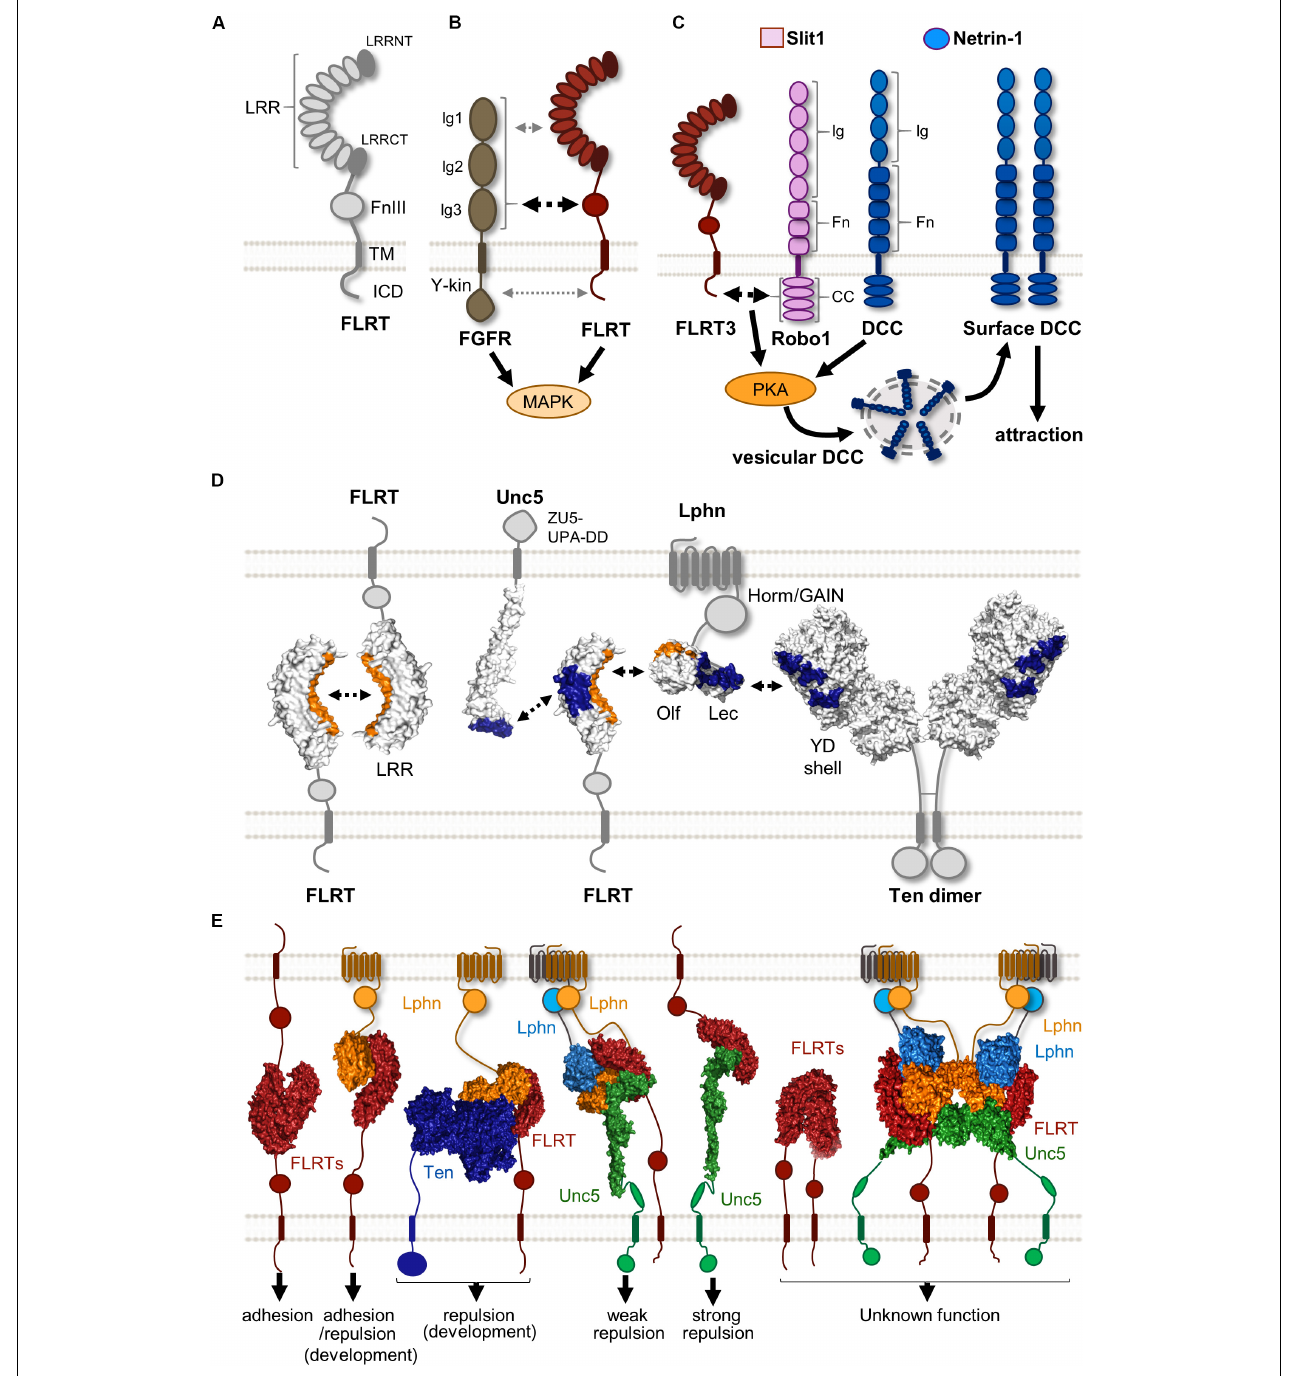
FIGURE 1 | Protein complexes formed by FLRTs and their binding partners. (A) Scheme showing the structure of FLRTs proteins and their main domains. (B) FLRT interact with FGFR through its FNIII domain (black dashed arrow) regulating MAPK activity. Other interactions through FLRT LRR and ICD have been suggested (gray dashed arrow). (C) Scheme representing the mechanism by which responsiveness to Netrin-1 is achieved in rostral TCAs. In the presence of Slit1 and Netrin-1 FLRT-Robo interaction enhances PKA activity, which in turn increases surface levels of DCC, thereby enabling Netrin-1 attraction. (D) Scheme illustrating the known surfaces involved in FLRT LRR-dependent interactions. LRR domains participate in homophilic and heterophilic binding with different binding partners. Surfaces interacting with the concave site of the FLRT LRR domain are labeled in orange, whereas those binding the convex site are labeled in blue. (E) Overview of the variety of binary and ternary structure arrangements formed by FLRTs and its binding partners. These complexes cover a variety of responses ranging from adhesion to repulsion. The biological function of some of these structures remains largely unknown. These are selected examples of published protein structures (Seiradake et al., 2014; Jackson et al., 2015, 2016; del Toro et al., 2020).